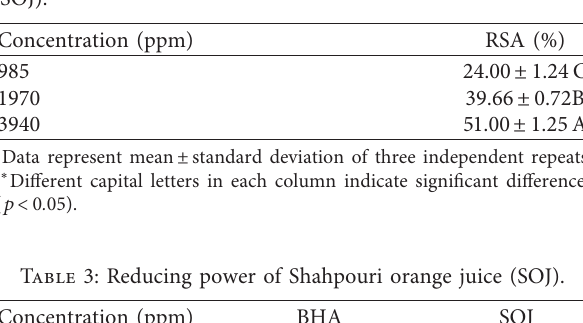
∗ Data represent mean ± standard deviation of three independent repeats. ∗∗ Different capital letters in each column indicate significant differences ( p < 0 . 05 ) . Table 2: Radical scavenging activity (%) of Shahpouri orange juice (SOJ).